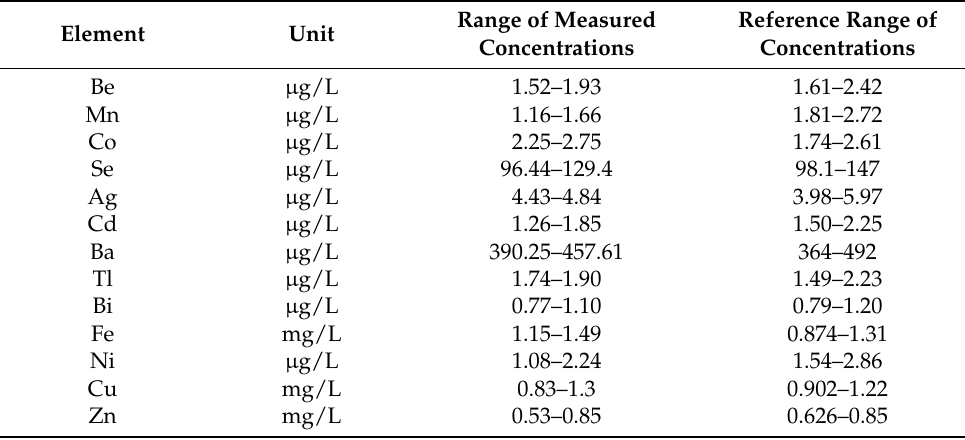
Table 7. Analysis of reference materials, ClinChek®—control trace